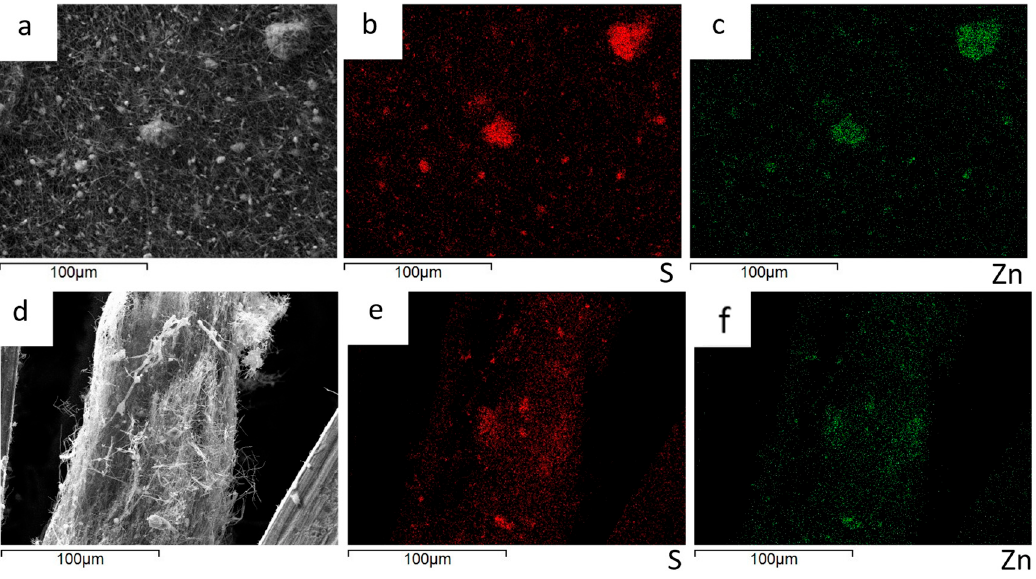
Figure 7. 30%ZnS–GO/CNF anode: sample surface portion ( a ) and distribution maps of S ( b ) and Zn ( c ); cross-section portion ( d ) and distribution maps of S ( e ) and Zn ( f ).